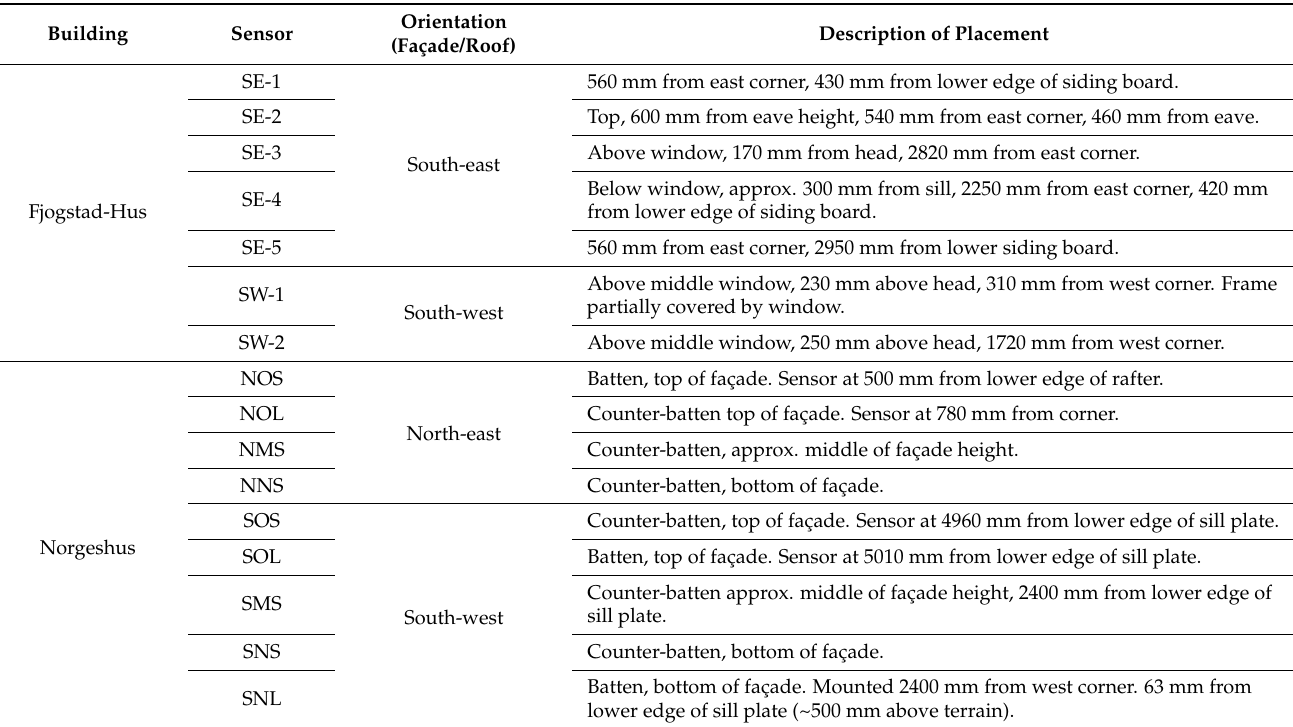
Figure 3. The location of the case buildings on a climate classification map of the Nordic countries according to the Köppen-Geiger classification system. All cities above 100,000 inhabitants are marked. Figure based on [67], used with permission. Table 1. The sensor positions in the case